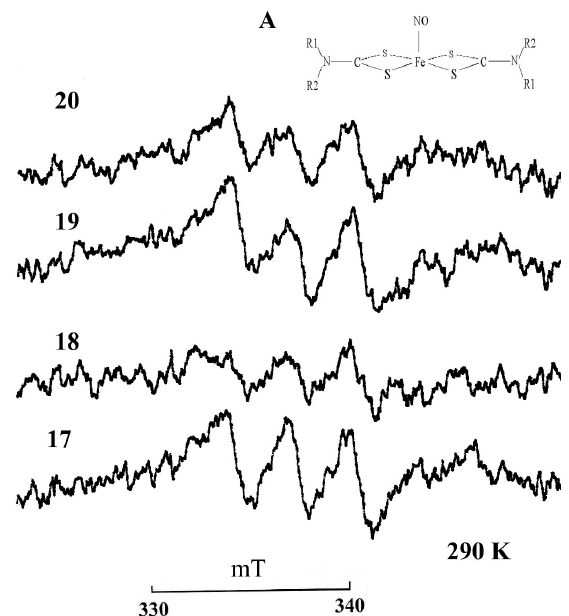
Figure 2. Concentration of serum nitrite in different groups of horses.